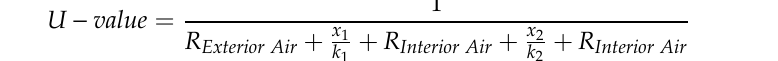
Figure 3. Alaska Small Shelter System exterior and interior. Representative of the fabric shelters being used in the HERDS model [33].